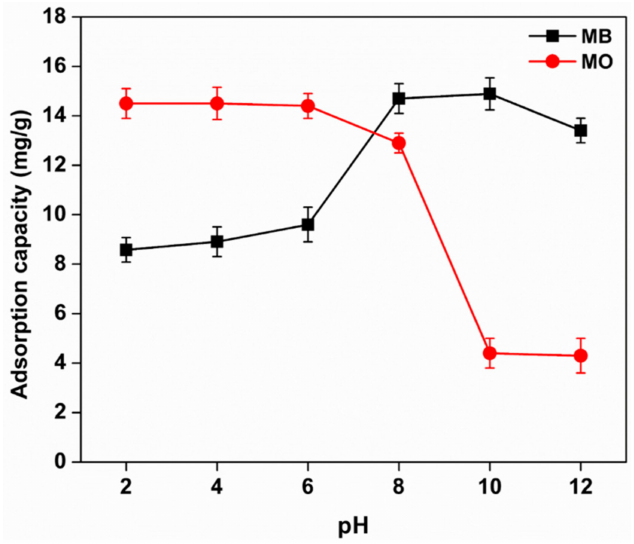
Figure 6. Effects of pH on the adsorption of Methylene blue (MB) and Methyl orange (MO) dyes onto the Kg-Ch sponge ( C 0 = 20 Mg/L; contact time: 120 Min; Mass of Kg-Ch = 20 Mg; temperature: 25 ◦